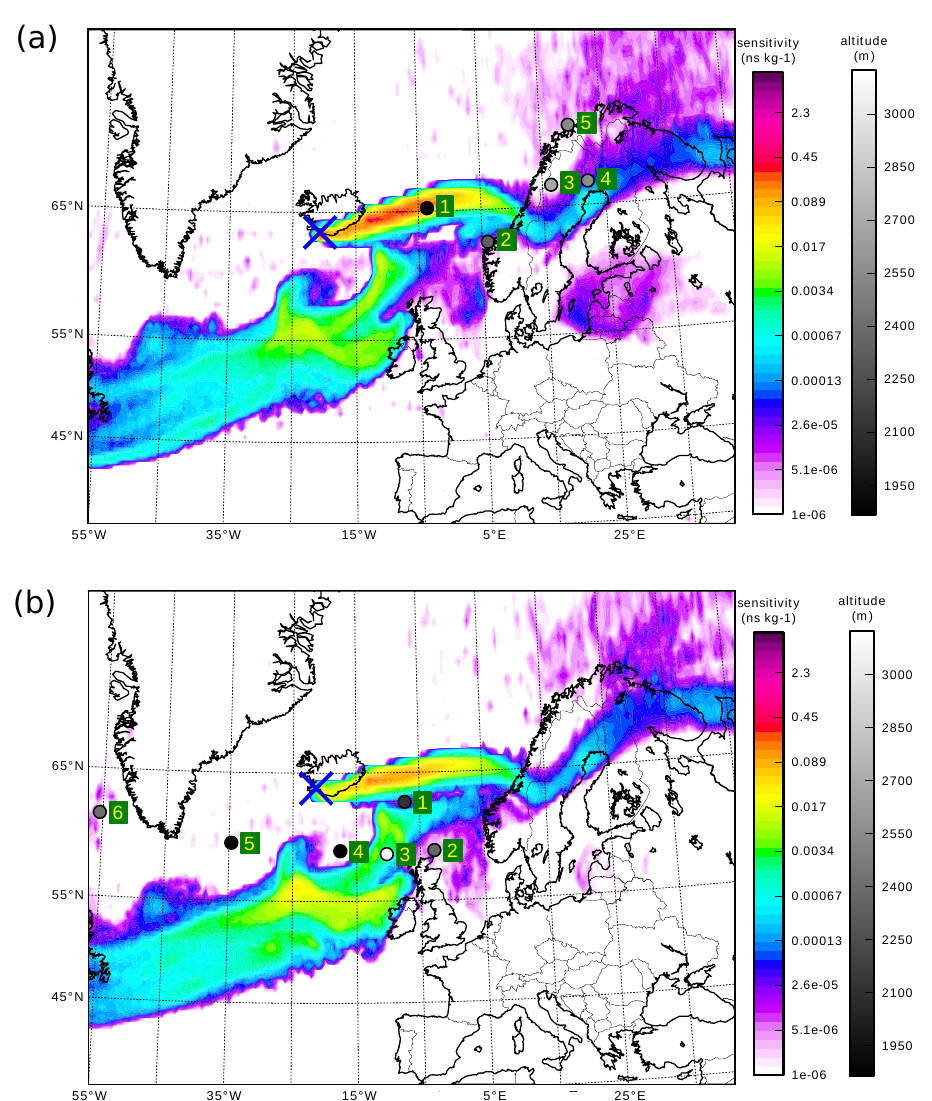
Fig. 16. Flexpart aerosol tracer footprint PES [ns/kg] (colored shadings) for (a) flight leg 5 (400m height) and (b) flight leg 3 (1900m height). Black circles represent plume centroid locations for a specific day back in time (see yellow numbers inside green boxes to the right of the circles for the corresponding day back in time). The circles are filled with a grey shading that represents the mean plume altitude [m]. The blue crosses near Iceland mark the aircraft measurement